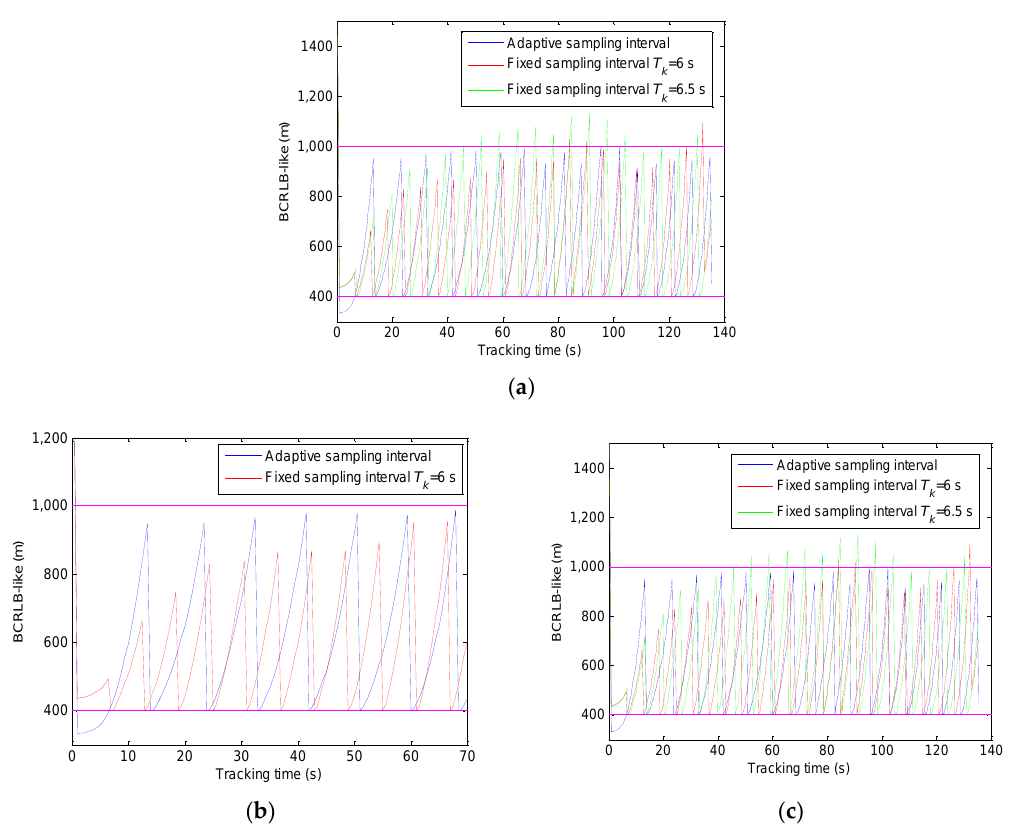
Figure 5. The comparison between the adaptive sampling interval and the fixed sampling interval with different tracking time ( a ) 0–135 s; ( b ) 0–70 s; ( c ) 70–135 s.